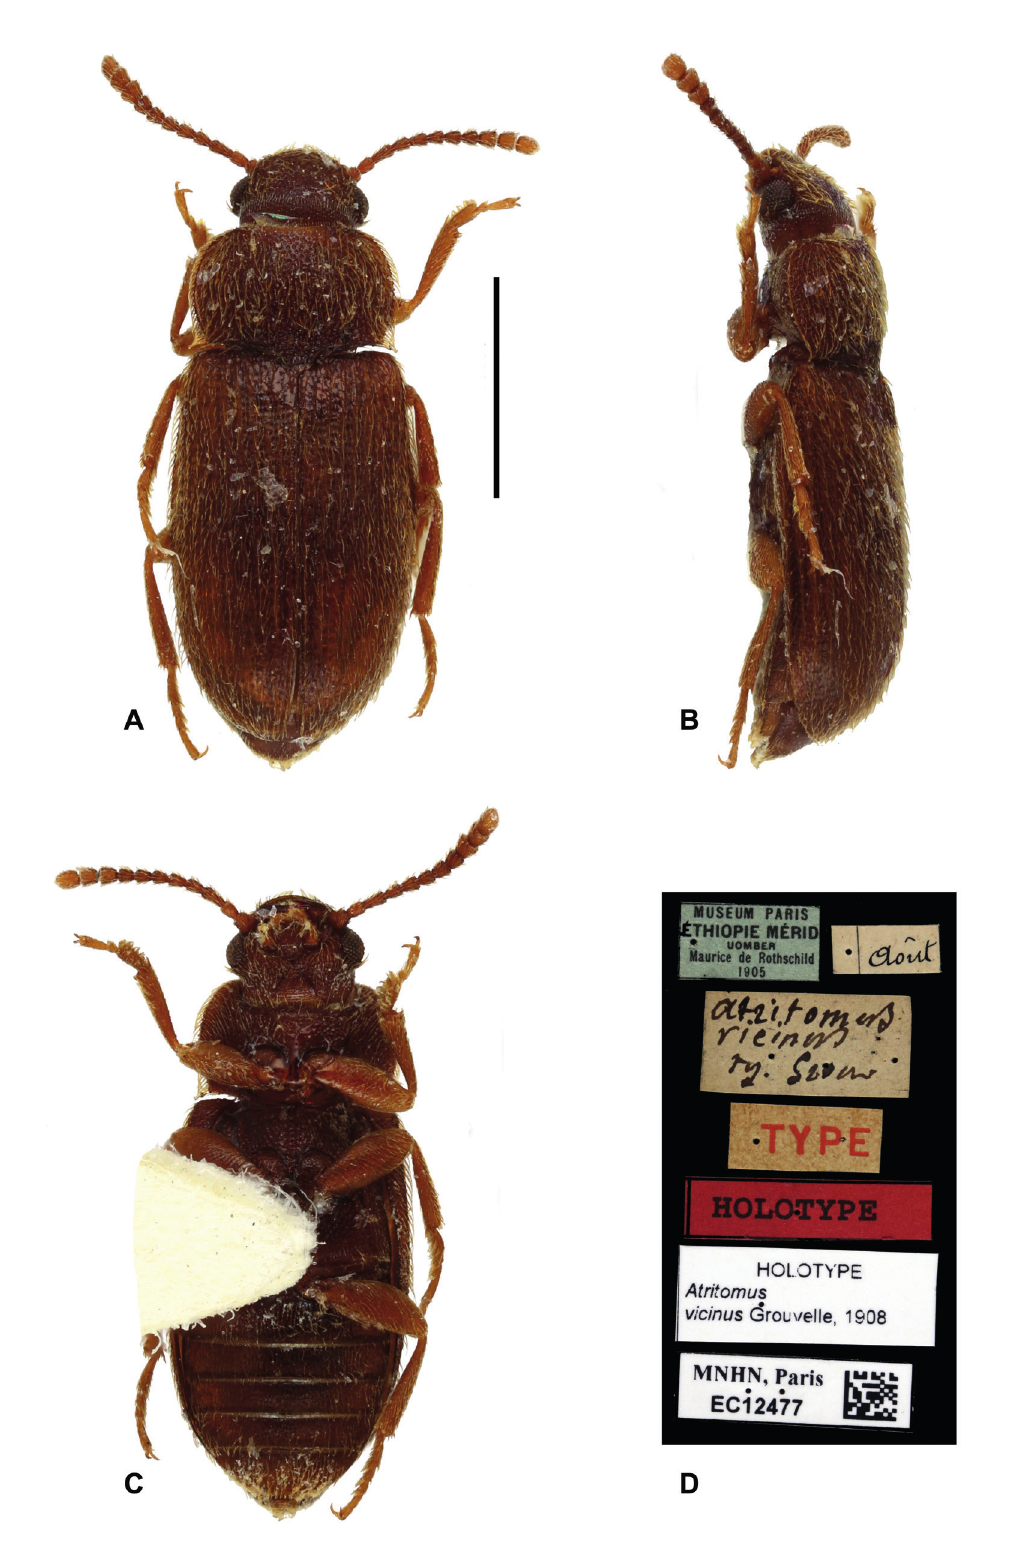
Fig. 2. Atritomus vicinus Grouvelle, 1908 (= Typhaeola vicina (Grouvelle, 1908) comb. nov.), holotype (EC12477). A . Habitus, dorsal view. B . Habitus, lateral view. C . Habitus, ventral view. D . Labels. Scale bar = 1